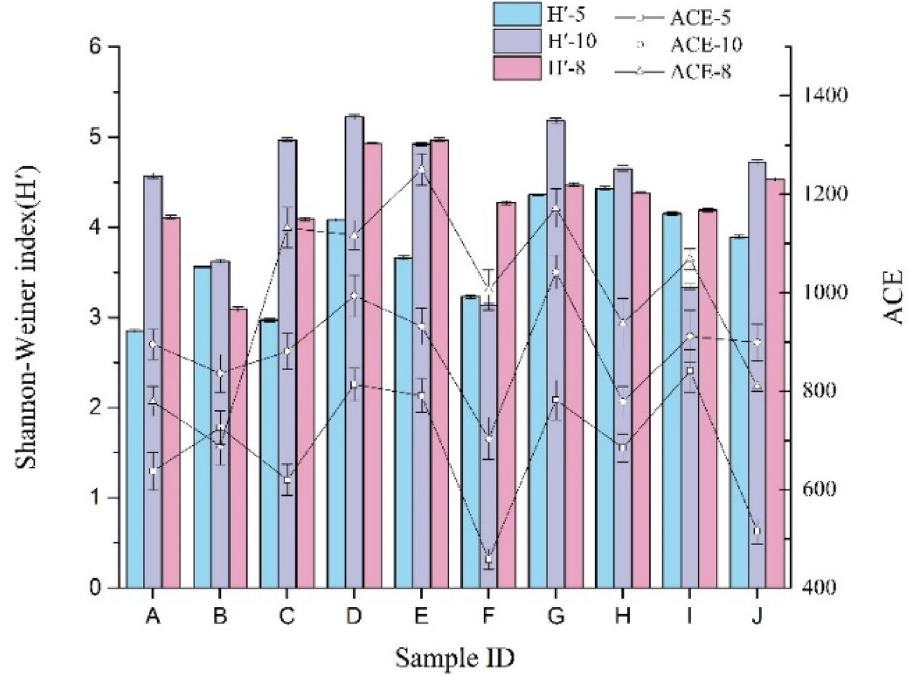
Figure 2. Biodiversity and abundance of the surface-flow constructed wetland in each unit.